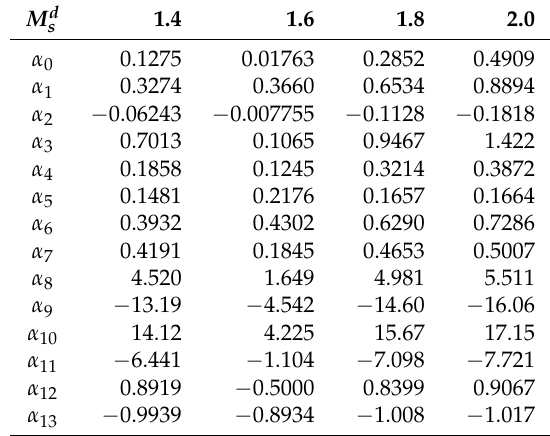
Table 5. Coefficient parameters α i ( M d s ) for κ p in the regulation mode.